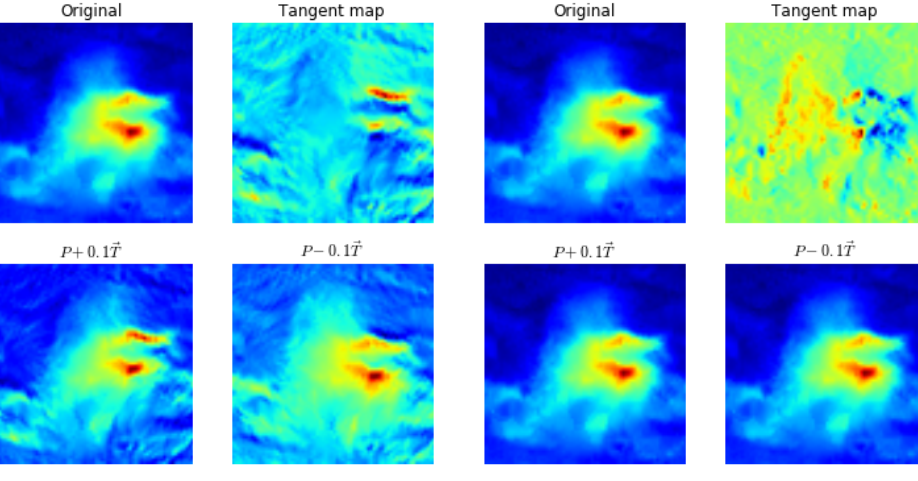
Figure 6. Scale transform ( left group ); and Y-translation ( right group ) at “2016-01-19